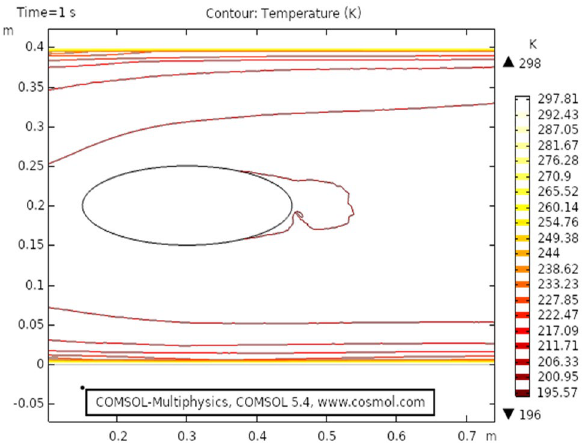
Figure 12. Isothermal contour temperature distribution in elliptic cylindrical flow at t = 1 s .